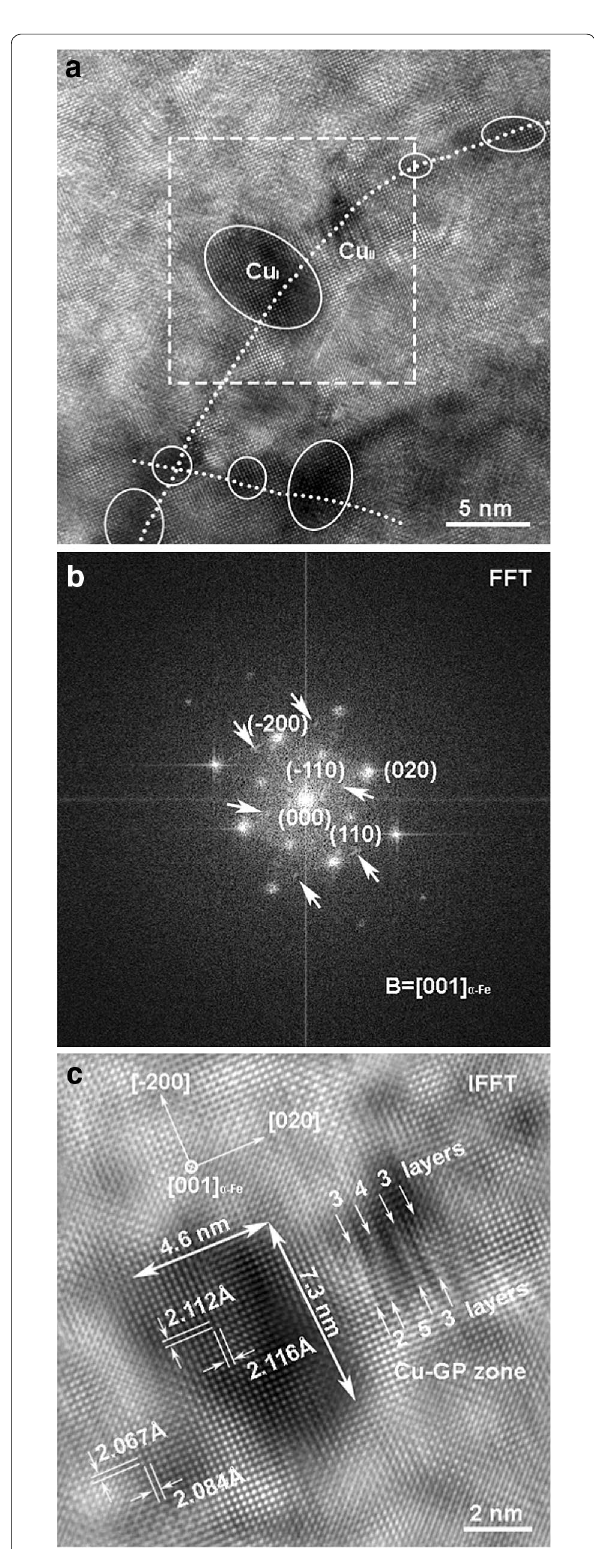
Figure 1 a HRTEM image of BCC Cu precipitates formed on dislocations and in α-Fe matrix; b FFT pattern of the region in dash square in a ; c IFFT image of b , showing two Cu-rich precipitates with different